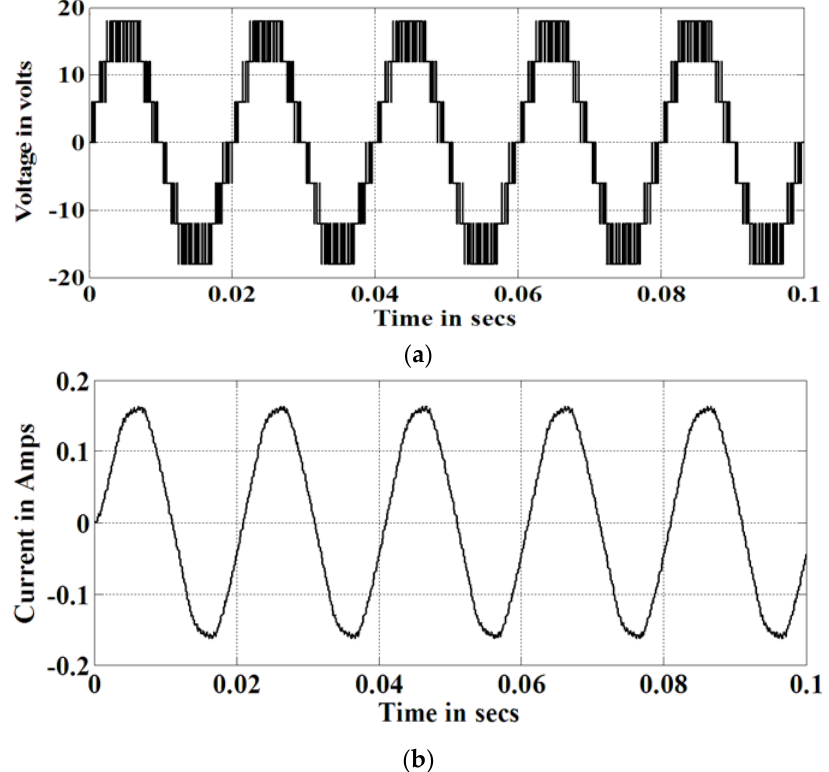
Figure 7. Output waveform for the PDPWM strategy. ( a ) Voltage; ( b ) Current.